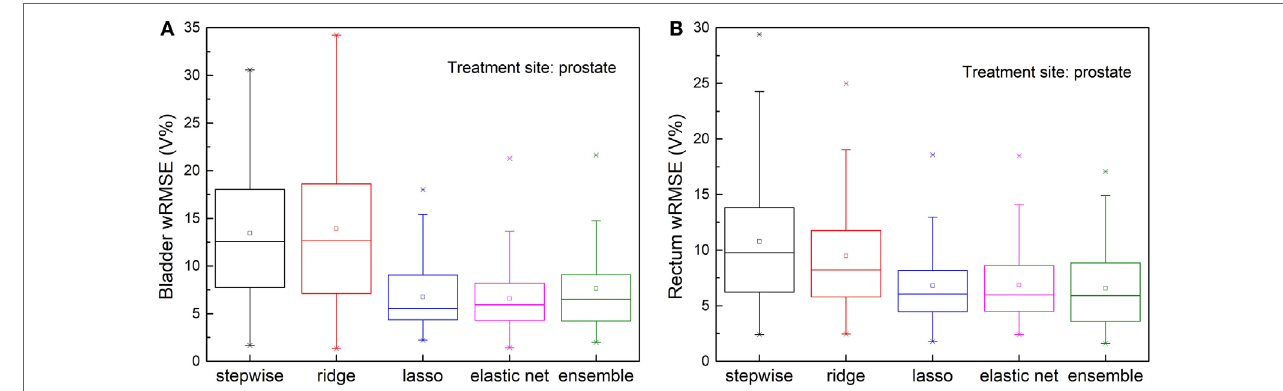
FigUre 6 | Prediction errors [Weighted root mean squared error (wRMSE)] of individual regression models and the proposed ensemble model for (a) bladder (B) rectum, in the presence of simulated dosimetric outliers (see text). For bladder prediction, the proposed ensemble method predicts significantly better than stepwise ( p < 0.001), ridge ( p < 0.001), and performs similarly well as lasso ( p = 0.753) and elastic net ( p = 0.841). For rectum prediction, the proposed ensemble method predicts significantly better than stepwise ( p < 0.001) and ridge ( p < 0.001), and performs similarly well as lasso ( p = 0.365) and elastic net ( p = 0.373).